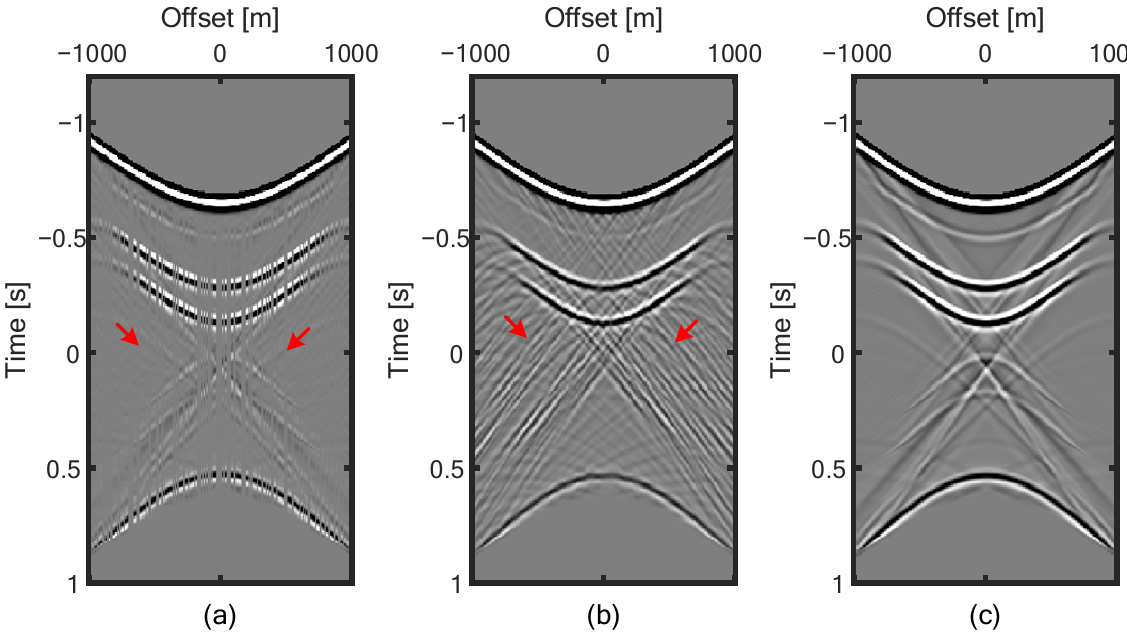
Figure 3. The focusing functions obtained by the standard Marchenko method integrated under the receiver dimension. They are sampled ( a ) under the source dimension; ( b ) under the receiver dimension; ( c ) regularly. Red arrows point out partial artifacts.